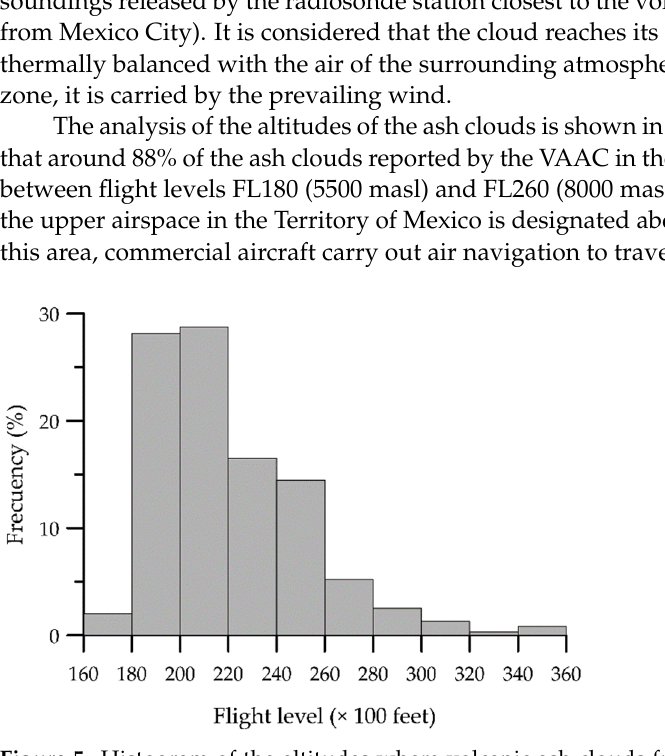
Figure 5. Histogram of the altitudes where volcanic ash clouds from Popocatepetl volcano were identified by the Washington VAAC in the period 2000 to 2021. The altitudes are expressed in the nomenclature of flight levels (FL) in hundreds of feet above sea